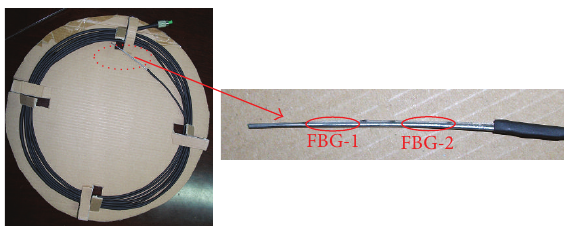
Figure 2: Packaged fiber Bragg grating sensors.